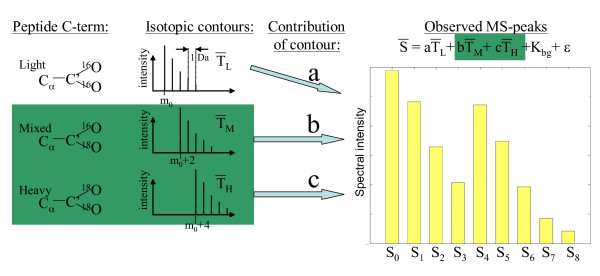
18O/16O labeling problem setting. To quantitatively compare peptides their C-term is ideally labeled with heavy oxygen (two 18O) or light oxygen (two 16O), but partial labeling also occurs (mixed). These isotope species give rise to overlapping isotopic contours with individual contributions (a, b and c) to the observed MS spectra peaks. The input data used for the data analysis were nine observed spectral intensities (S0-S8) including possible missing values. These intensities () are assumed to equal a weighted sum of three isotope contours (Peptide C-terms:  Light (16O2),  Mixed (18O, 16O) and  Heavy (18O2)), a constant background Kbg and an error term ε. The weights (a, b and c) are of particular interest since they describe the contribution of unlabelled (Light:a) and labeled (Mixed:b and Heavy:c) isotopes. In the theoretical case where the background constant and error term are removed a theoretical framework is presented (see Table 1), where the above experiment is performed twice for each peptide with swapped labels (i.e. Direct and Inverted experiments).